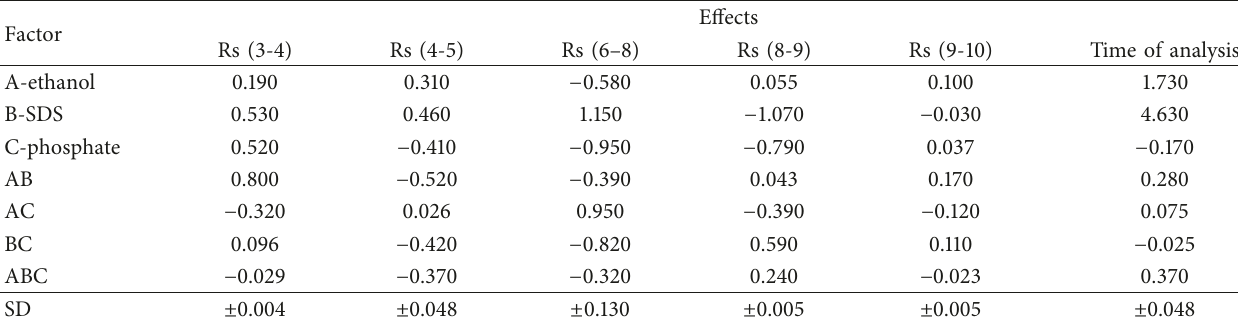
Table 3: Main effects, interaction among the variables, and time of analysis.